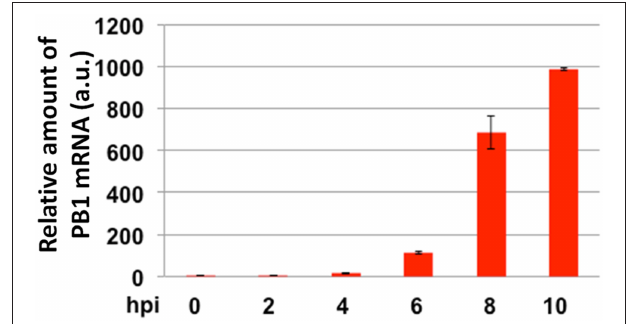
FIGURE 5 | The fluorescence images of the immunostaining of non-infected cells (–V) and virus-infected cells from 1 to 5 h post-infection (hpi) (Blue: nucleus; Red: nanoprobes, Green: PB1 viral protein). Scale Bar: 20 µ m.